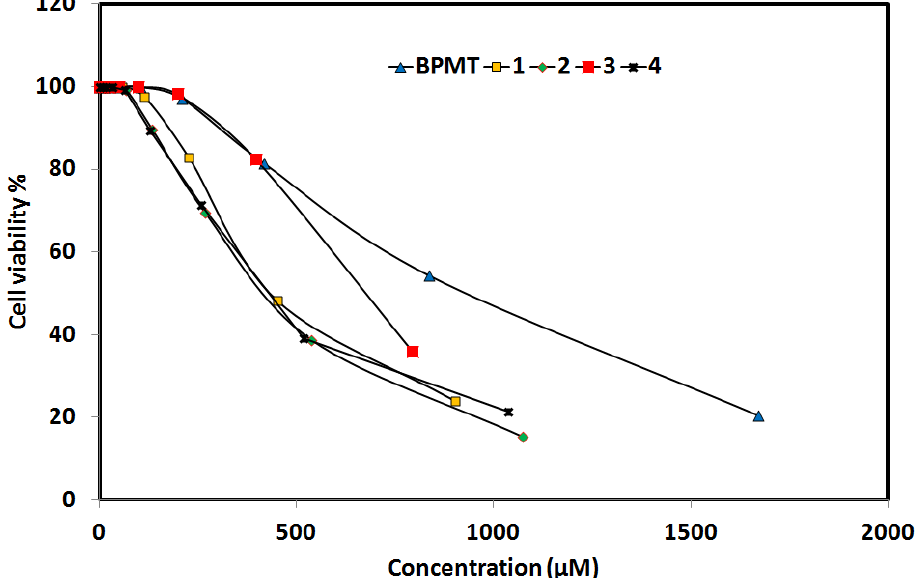
Figure 7. The cytotoxic activity of the studied compounds against MCF-7 cell line.